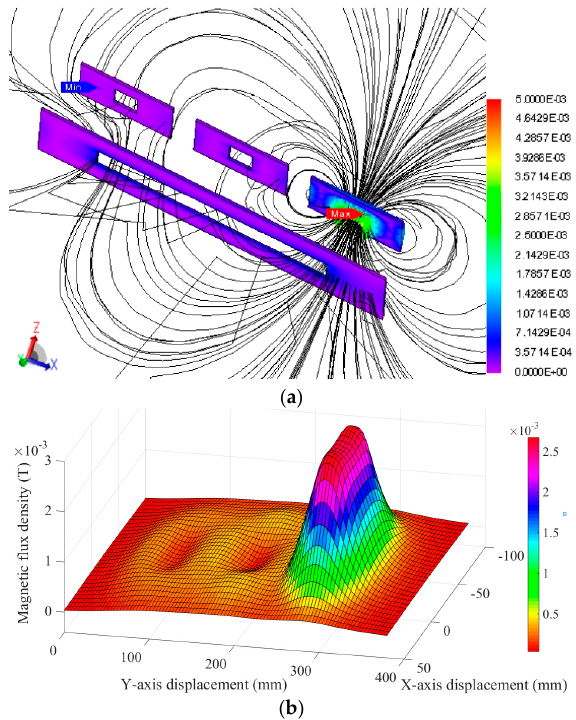
Figure 4. Electromagnetic field analysis at resonant frequency of 100 kHz: ( a ) magnetic flux line distribution; and ( b ) magnetic flux density distribution.